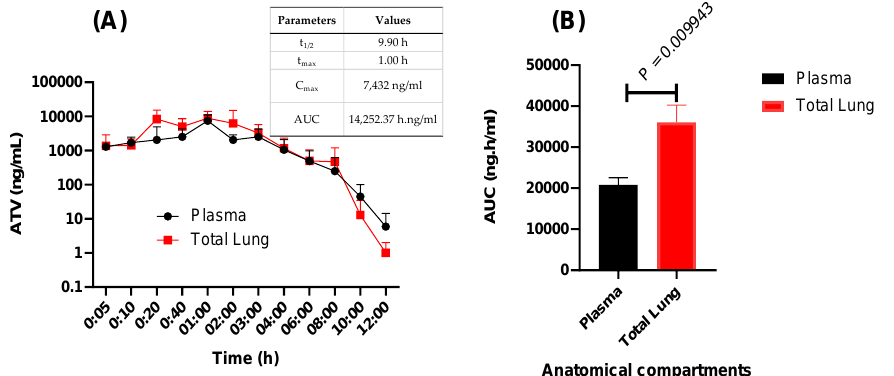
and cell-based inflammation on cells counts of polymorphonuclear and mononuclear cells (Figure 4E,F).